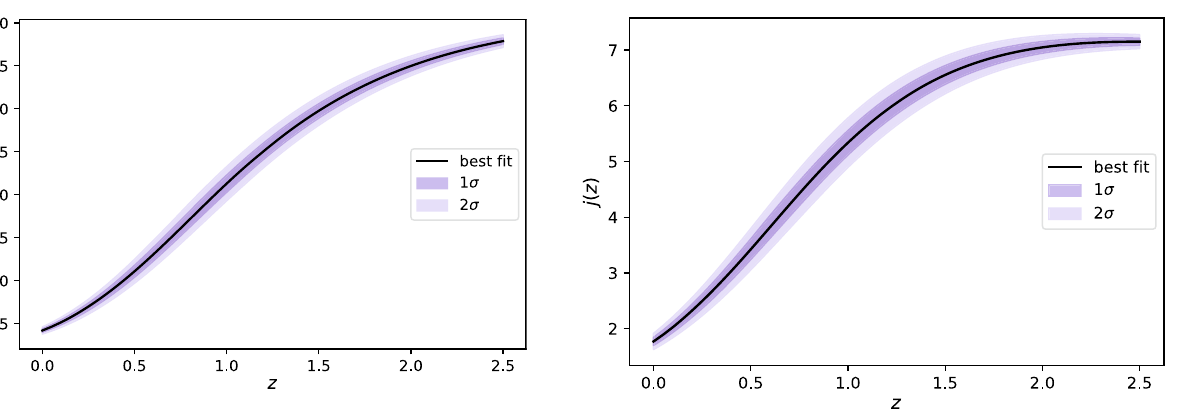
Fig. 10 The jerk parameter j ( z ) plot for Model I I I using the best fit values and the associated 1 σ , 2 σ confidence regions from the combined